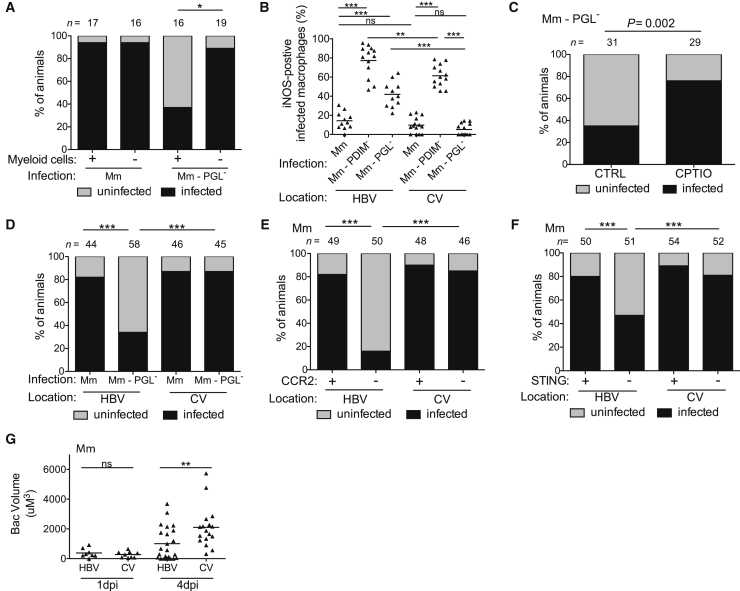
Resident Macrophages Are More Microbicidal than Monocytes(A) Percentage of infected (black) or uninfected (gray) wild-type or myeloid-deficient fish at 5 dpi after HBV infection with 1–3 wild-type or PGL− Mm. n = number of larvae per group.(B) Percentage of iNOS-positive infected myeloid cells in the HBV or CV at 3 dpi with 80 wild-type, PDIM− or PGL− Mm.(C) Percentage of infected (black) or uninfected (gray) wild-type fish at 5 dpi after HBV infection with 1–3 PGL− Mm. Control, CTRL; Reactive nitrogen species scavenger CPTIO. n = number of larvae per group.(D) Percentage of infected (black) or uninfected (gray) wild-type fish at 5 dpi with 1–3 wild-type or PGL− Mm into the HBV or CV. n = number of larvae per group.(E) Percentage of infected (black) or uninfected (gray) wild-type or Ccr2-deficient fish at 5 dpi with 1–3 wild-type Mm in the HBV or CV. n = number of larvae per group.(F) Percentage of infected (black) or uninfected (gray) wild-type or Sting-deficient fish at 5 dpi with 1–3 wild-type Mm in the HBV or CV. n = number of larvae per group.(G) Mean bacterial volume at 1 and 4 dpi with a single wild-type Mm bacterium in the HBV or CV of wild-type fish.Results in (A)–(G) representative of three independent experiments. (B) and (G) significance testing done using one-way ANOVA, with Bonferroni’s post-test for comparisons shown. (A) and (C)–(F) significance testing done using Fisher’s exact test for the comparisons shown. ∗p < 0.05, ∗∗p < 0.01, ∗∗∗p < 0.001.